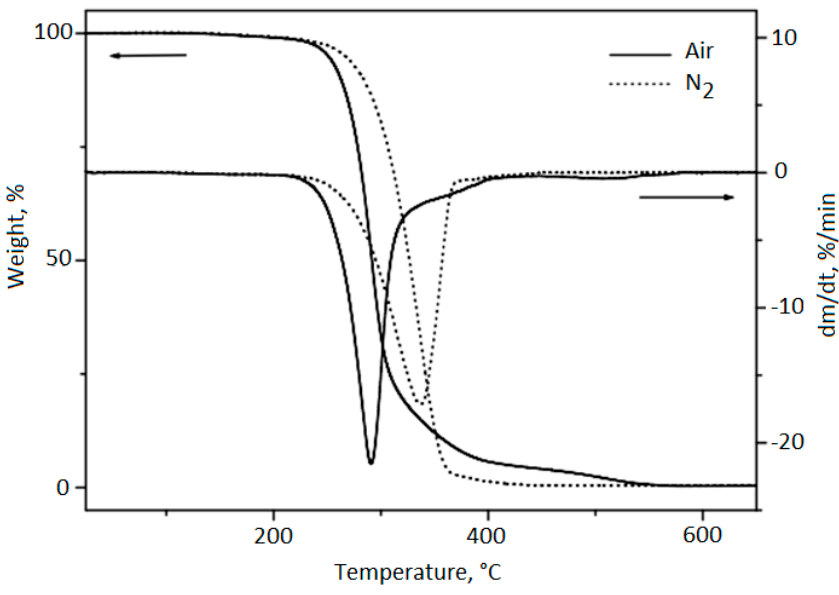
Figure 2. TG / DTG curve: Mass loss of babassu oil in an oxidative atmosphere of synthetic air and nitrogen under dynamic condition.